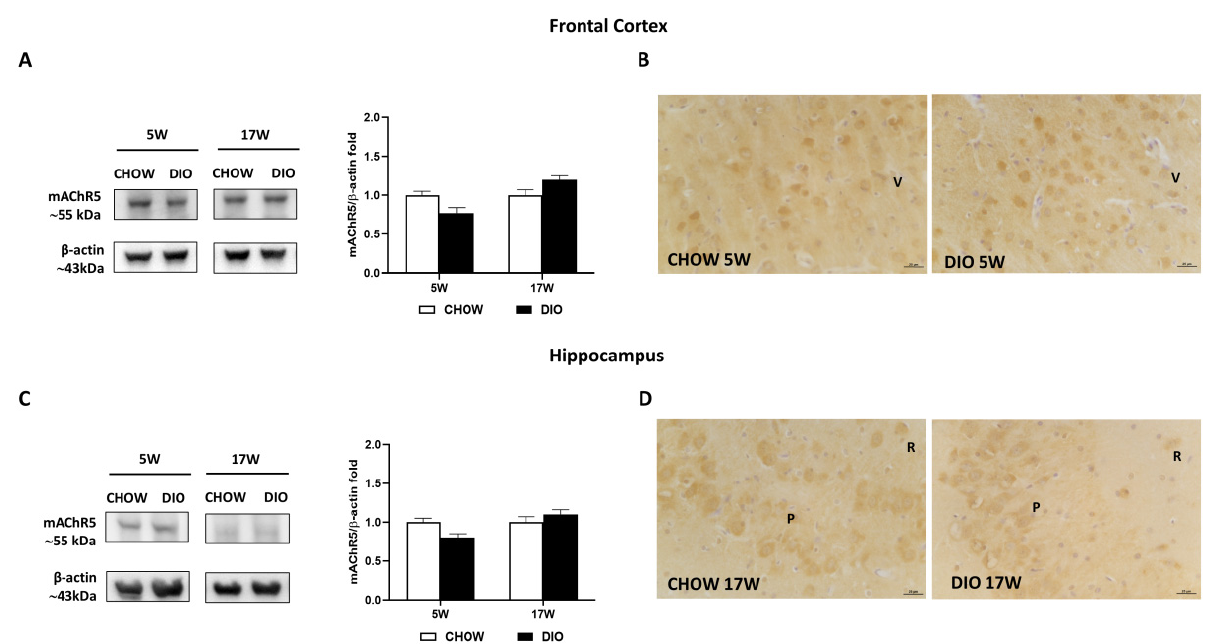
Figure 7. Western blot and immunohistochemistry of muscarinic acetylcholine receptor subtype 5 (mAChR5). Samples of the frontal cortex ( A ) and hippocampus ( C ) from rats fed with a standard diet (CHOW rats) and high-fat diet (DIO rats) for 5 and 17 weeks were immunoblotted using specific anti- mAChR5. Graphs report the densitometric data with CHOW rats as control, and β -actin was used as a reference loading protein. Data are mean ± S.E.M. CHOW rats 5 weeks n = 8; DIO rats 5 weeks n = 8; CHOW rats 17 weeks n = 8; DIO rats 17 weeks n = 9. Representative pictures of CHOW and DIO rats frontal cortex after 5 weeks ( B ) and hippocampus, CA3 subfield, after 17 weeks ( D ) of diet. V, fifth layer of frontal cortex; P, pyramidal neurons; R, stratum radiatum . Scale bar: 25 µ